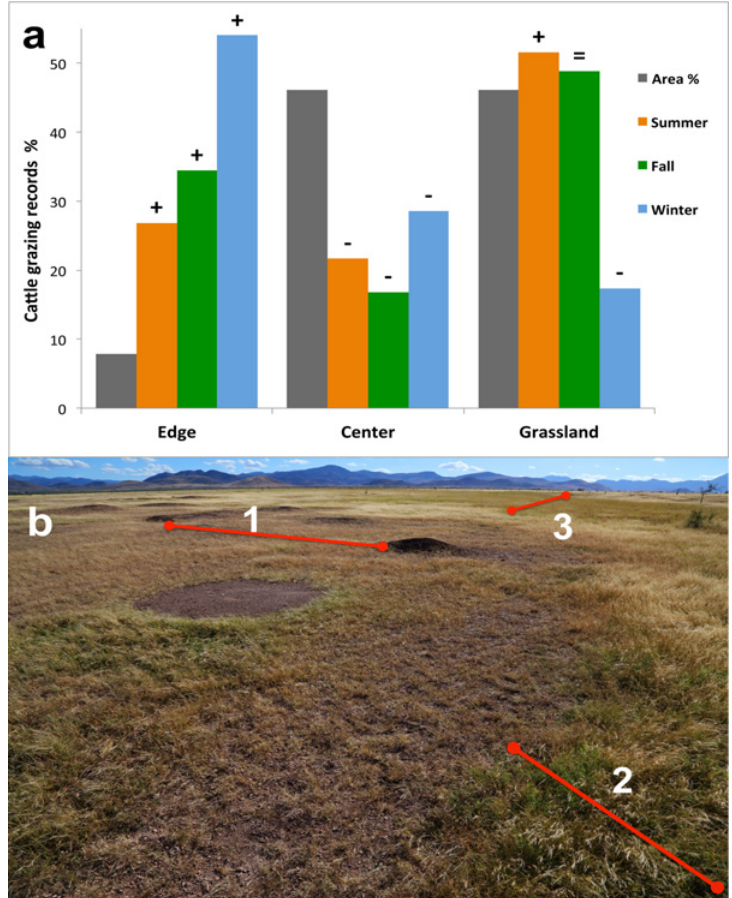
Fig 3. Small-scale experiment. Cattle grazing record ’ s percentage by foraging zone and season v.s. foraging zone area cover %. (a) Bonferroni confidence-interval results (P < 0.001) are given by the following signs: “ + ” indicates preference (utilization above availability); “ = ” indicates random (utilization equal to its availability); and “–” indicates avoidance (utilization below its availability); (b) image of a typical prairie dog colony in the Janos grasslands, showing vegetation height and cover increasing away from the colony center (1) towards the colony edge (2) and the surrounding climax grasslands (3).